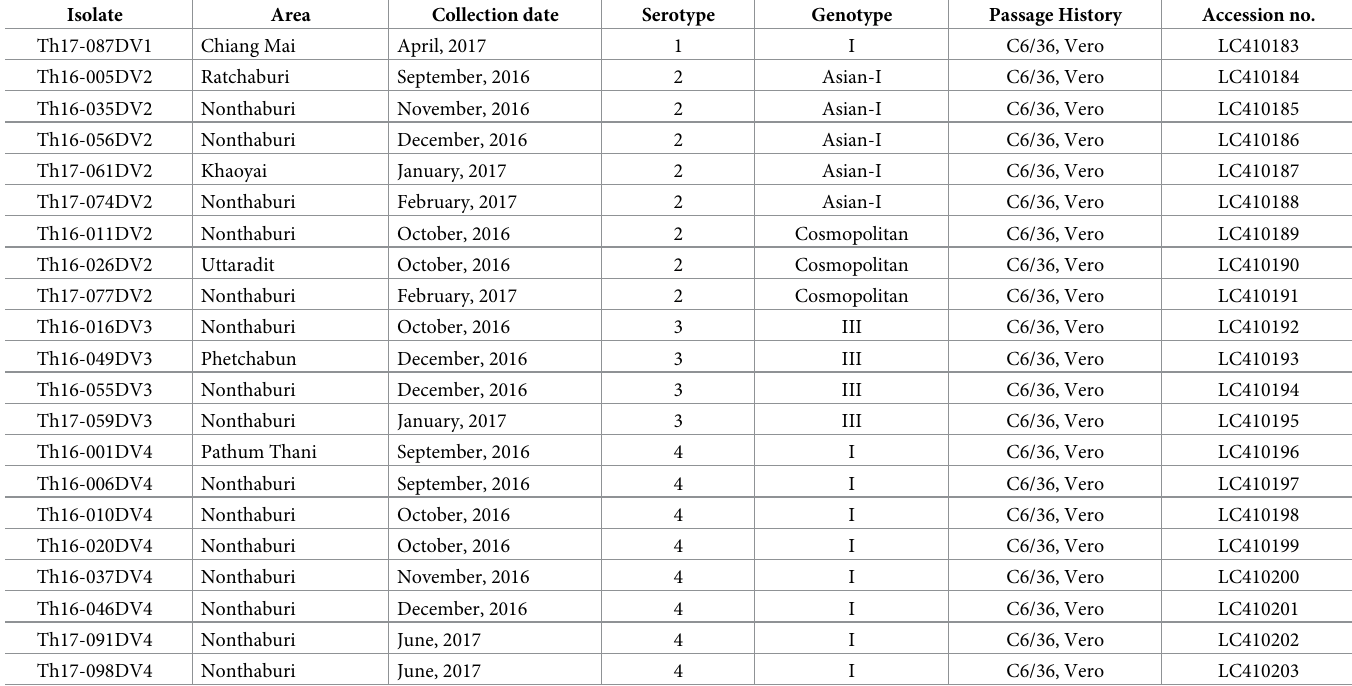
Table 1. Dengue virus isolates characterized in the present